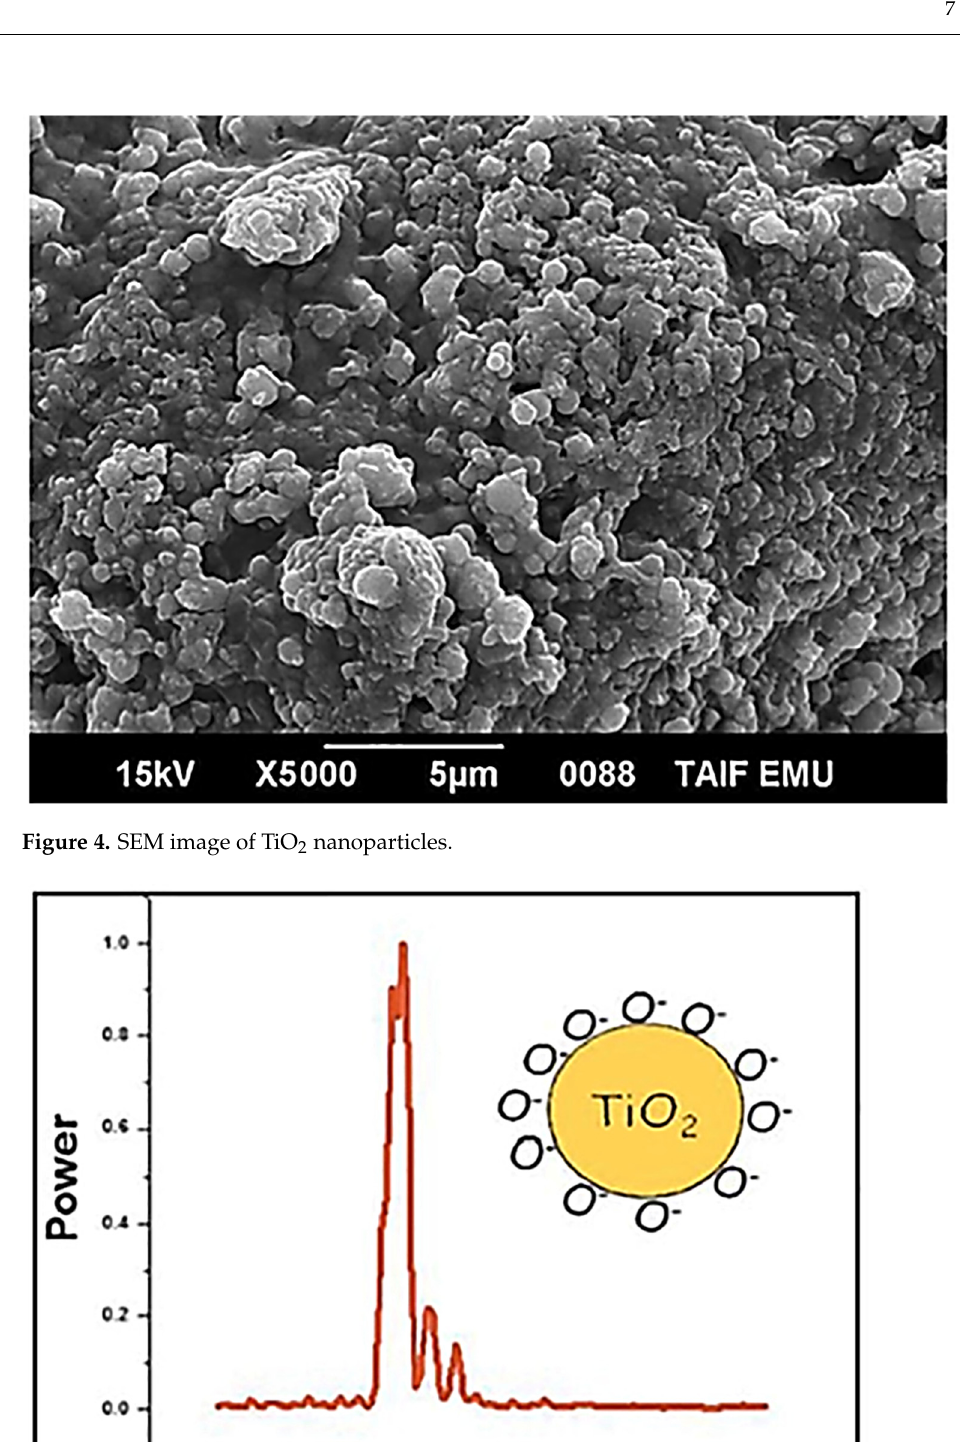
Figure 5. Zeta potential plot of TiO 2 NPs dispersed in water. The inset shows the behavior of TiO 2 in the suspension.